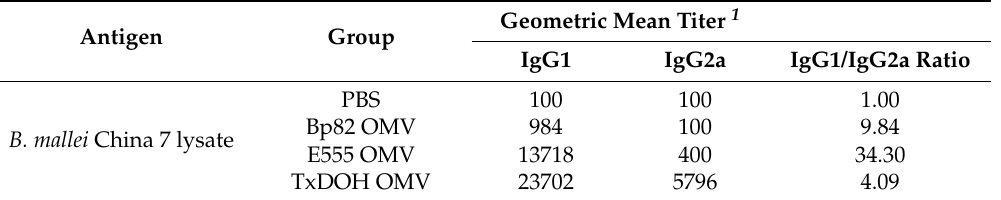
Table 1. OMV immunizations induce B. mallei specific IgG1 and IgG2a responses.